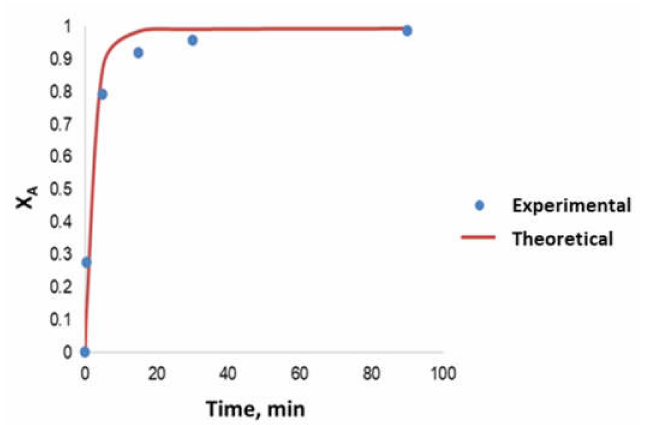
Figure 10. Theoretical and experimental conversions for the final experiment (FAME/alcohol mole ratio, 1/1; catalyst concentration, 1.5%; reaction temperature, 120 ◦ C; reaction time, 90 min; stirring rate, 500